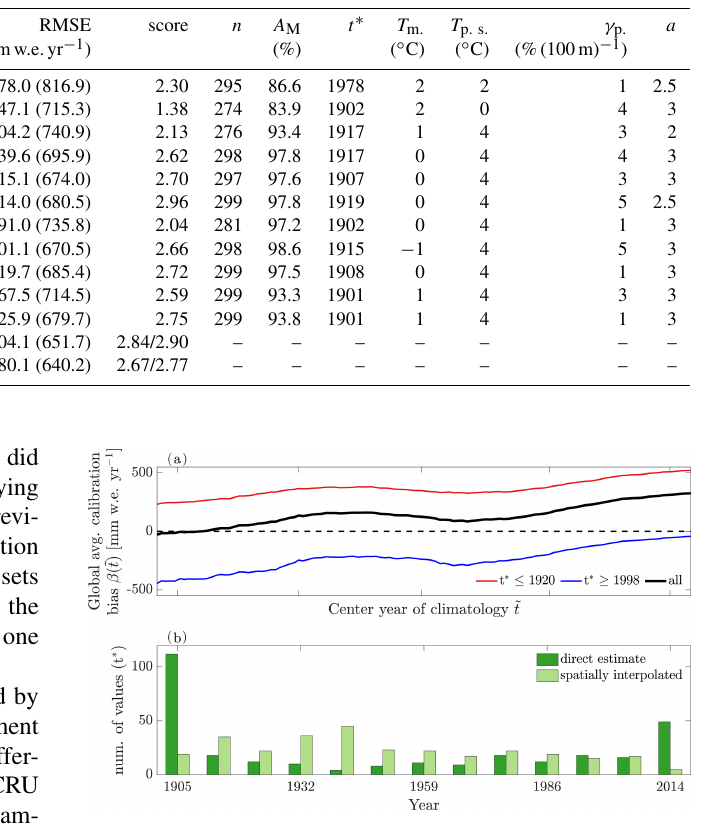
Figure 2. (a) Average calibration bias β as a function of the center year of a climatological window around ˜ t for validation glaciers showing the lowest calibration bias around the center years t ∗ ≤ 1920 (red, n = 132) and ≥ 1998 (blue, n = 72) as well as the weighted average of all validation glaciers (black, n = 298). (b) Distributions of t ∗ directly estimated from Eqs. (5) and (6) (green) and spatially interpolated as in Marzeion et al. (2012, light green). Values in both panels are derived from the cross-validation procedure (see Sect. 2.2.2 and 2.3) with the optimized CRU TS 4.03 model